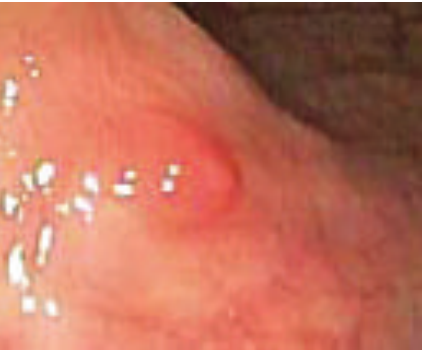
Figure 1: Endoscopic image of the 0.6 cm sessile polyp found in the cecum.